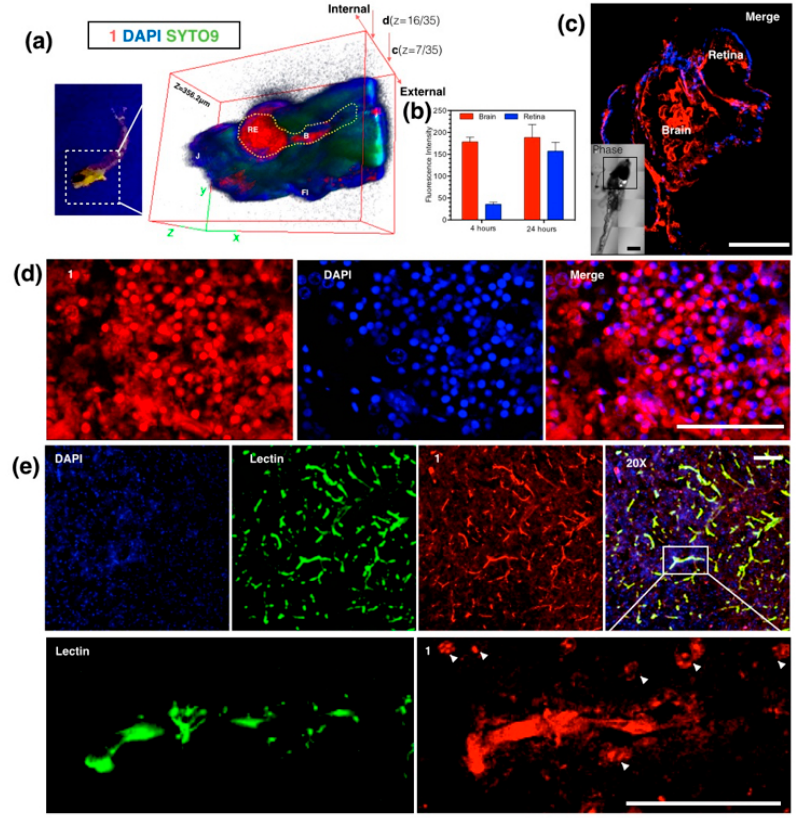
Figure 23. ( a ) Anaesthetized Larval zebrafish bath with 86 (100 nM) for 24 h under UV light (left) and 3D micrographs (thickness = 356.2 μ m) under two-photon confocal microscopy in larval zebrafish brain and retina at 4 and 24 h; ( c ) Whole brain region imaging of staining larval zebrafish by 86 co-stained with DAPI (4,6-diamino-2-phenyl indole), insert: DIC tile scanning of the imaged larval zebrafish; ( d ) Braco-stained with DAPI, Syto9 and Propidium Iodide; ( b ) Fluorescence intensity analysis of uptake of 86 in sections of staining adult zebrafish by 86 co-stained with DAPI; ( e ) Ex vivo assessment of 86 following i.v. injection in mice co-labeled with DAPI and Alexa488-lectin, and zoom in (200×) micrographs show the detail of brain capillaries imaged by confocal laser scanning microscopy, with strong internalization of 86 with brain endothelium and CNS (central nervous system) cells at nuclear and plasma membrane. The scale bar represents 200 μ m. Error bars: SEM (scanning electron microscope), n = 3. Abbreviations: Re = retina, B = brain, J = jaw, FI = fin.